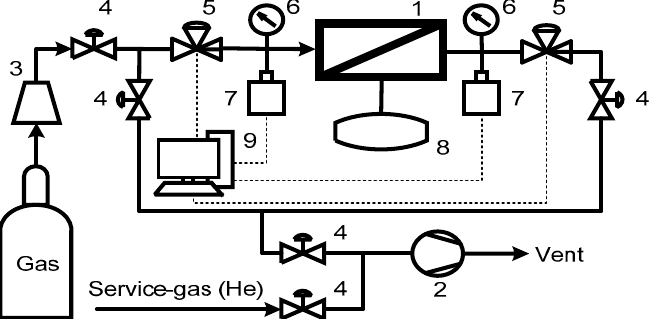
Figure 2. Schematic of experimental setup for single gas permeability test: 1 = permeation cell; 2 = vacuum station; 3 = pressure reducer; 4 = manual valves; 5 = pneumatic valves; 6 = pressure gauges; 7 = pressure transducers; 8 = additional volume for the permeate side; and 9 = workstation.